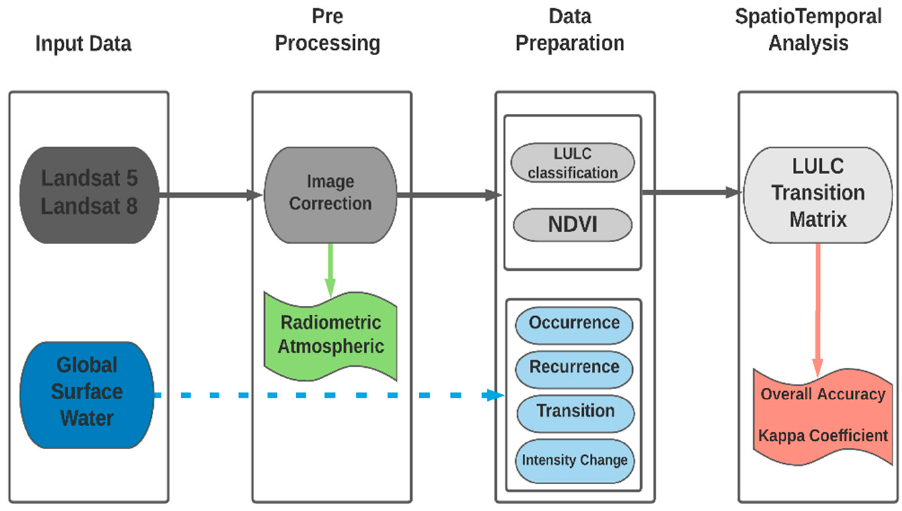
Figure 2. Flowchart of the methodology.